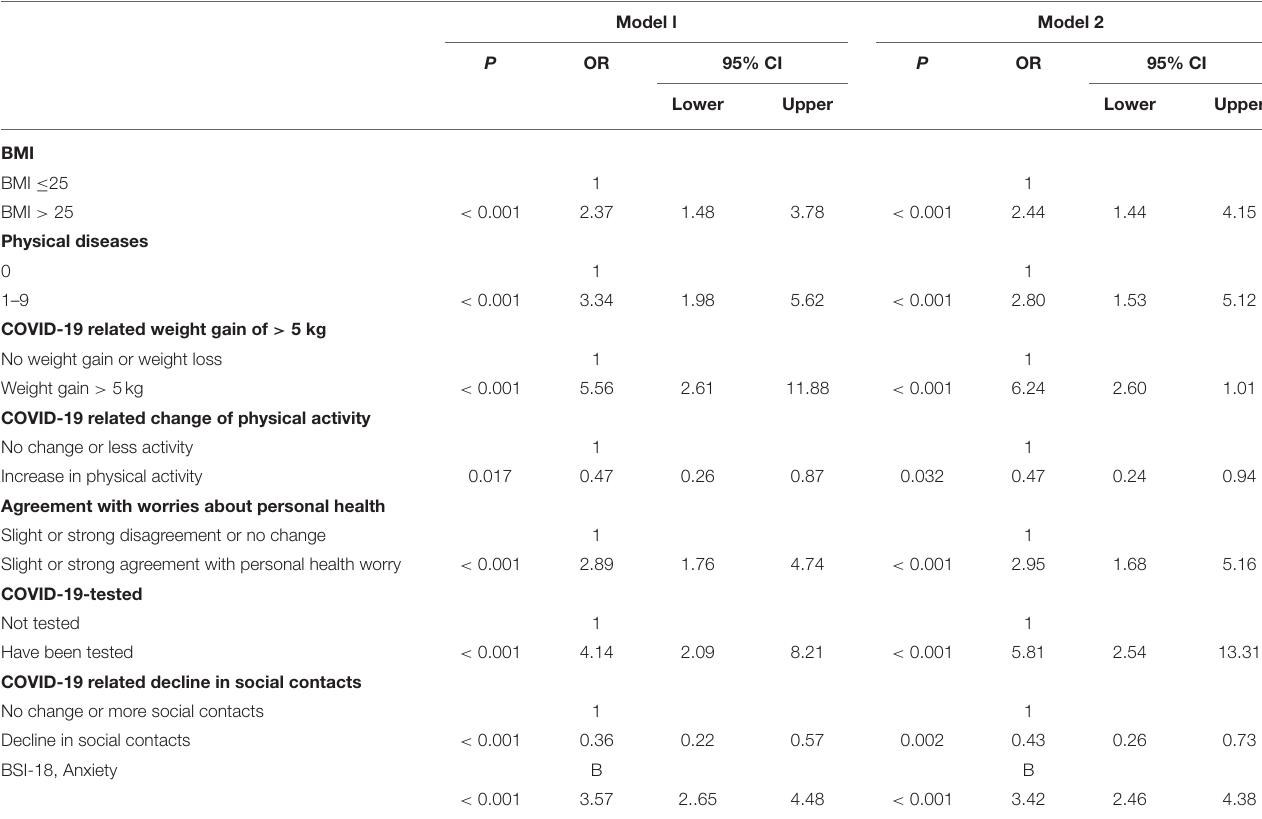
TABLE 2 | Physical health status, behavioral indicators, and anxiety in patients with BD ( n = 118) and healthy control individuals ( n = 215) adjusted for age and sex, basic model 1 and the fully adjusted model 2, additionally including relationship status and educational